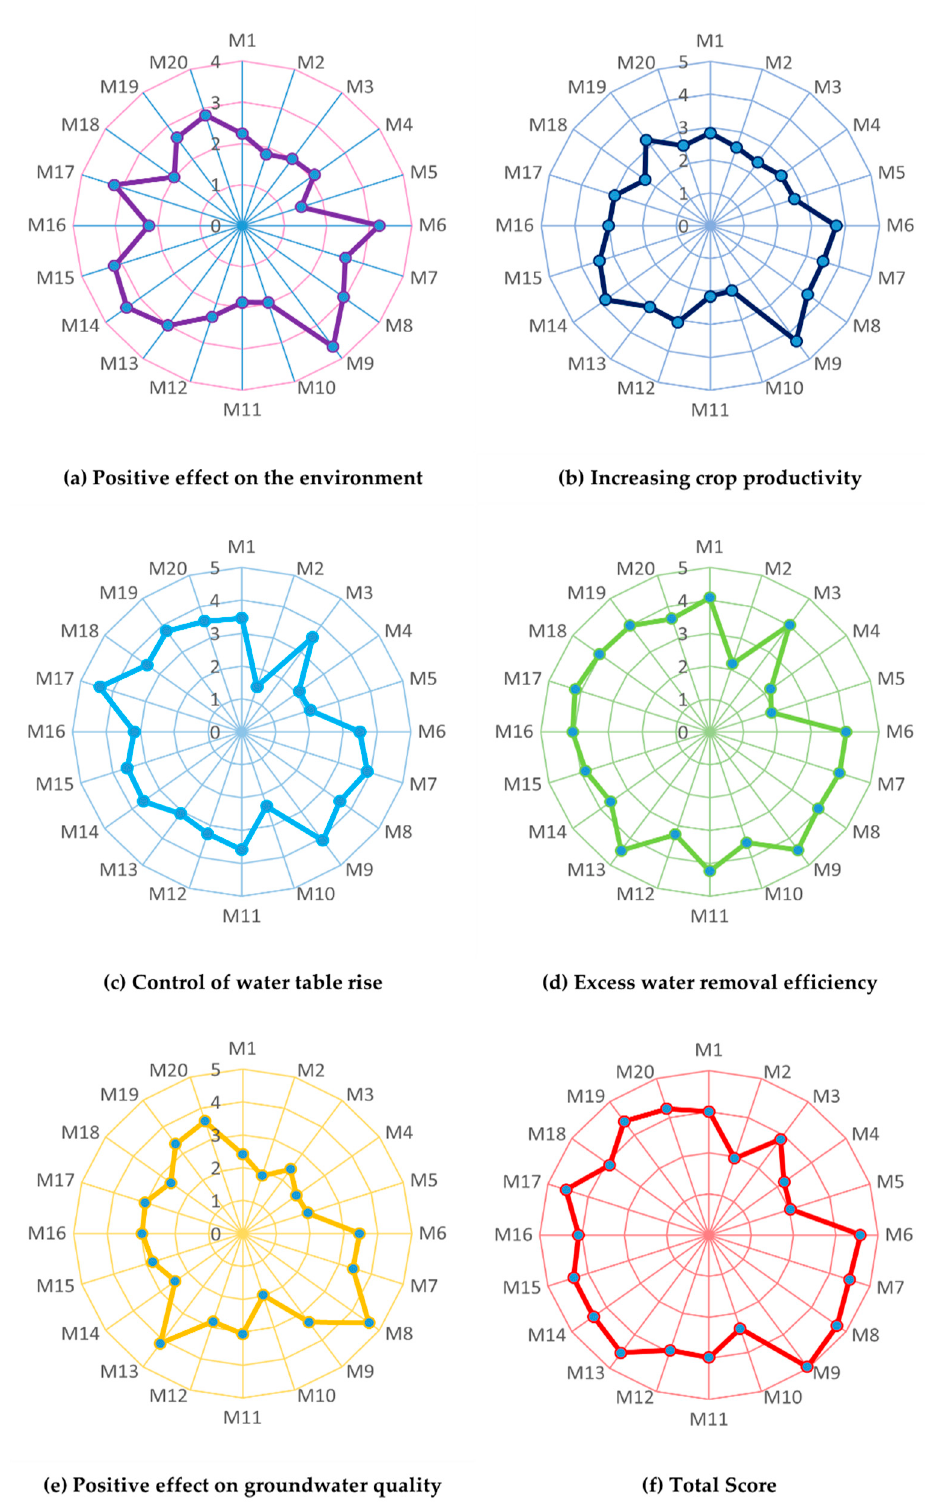
Figure 2. Result of the methods evaluation questionnaire.